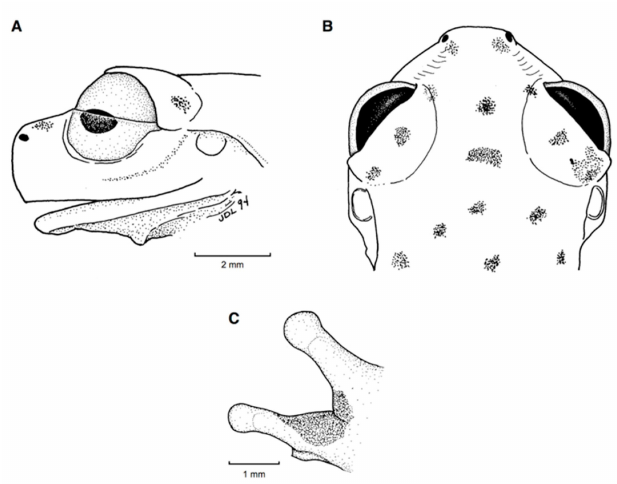
Figure 72. Cochranella litoralis , holotype, adult male, ICN 13821. ( A ) Head in lateral view. ( B ) Head in dorsal view. ( C ) Fingers I and II in dorsal view; note that nuptial pad extends on the two fingers;